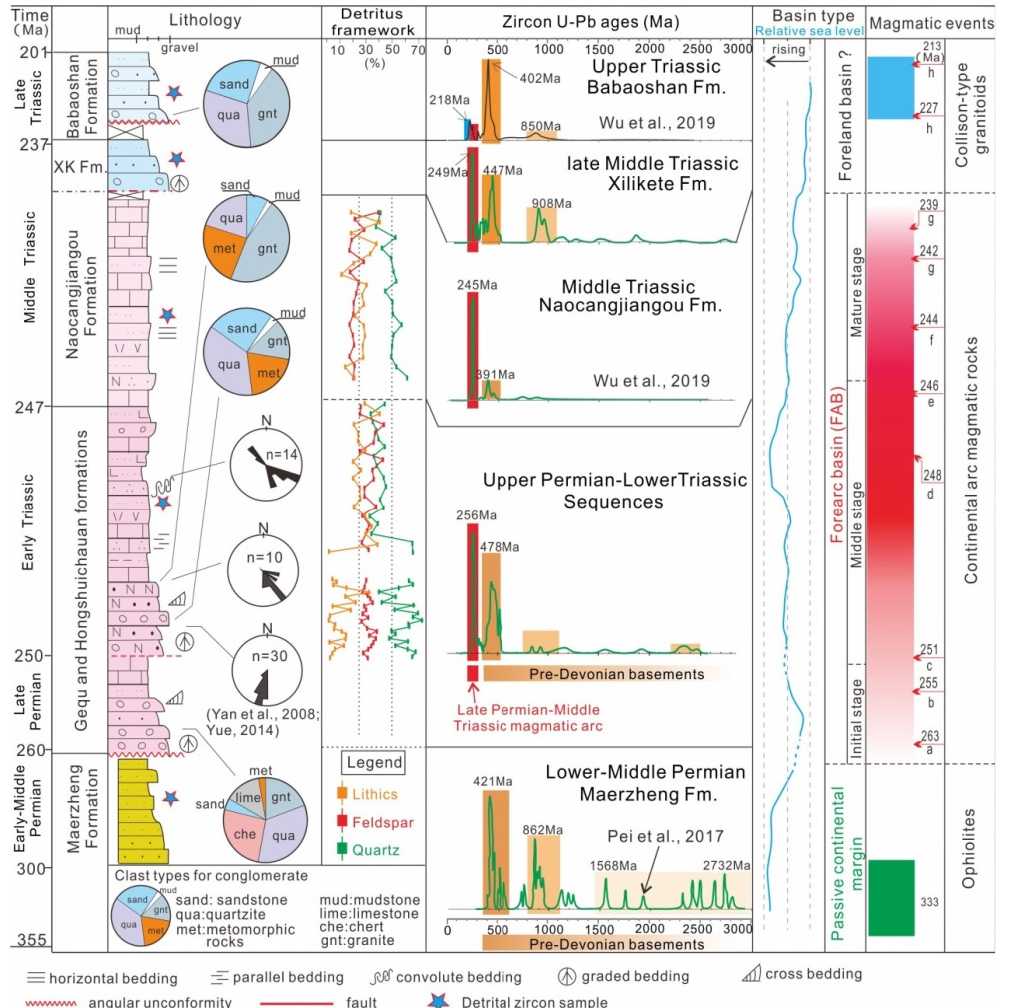
Figure 16. Summary of Late Paleozoic–Early Triassic sedimentary successions, sandstone detritus framework, and detritus zircon ages spectrum. XK Fm.-Xilikete Formation (magmatic events from Li et al. [49,50]; Age data of Babaoshan and Naocangjiangou formations from Wu et al. [20]; Age data of Maerzheng Formation from Pei et al. [14]).